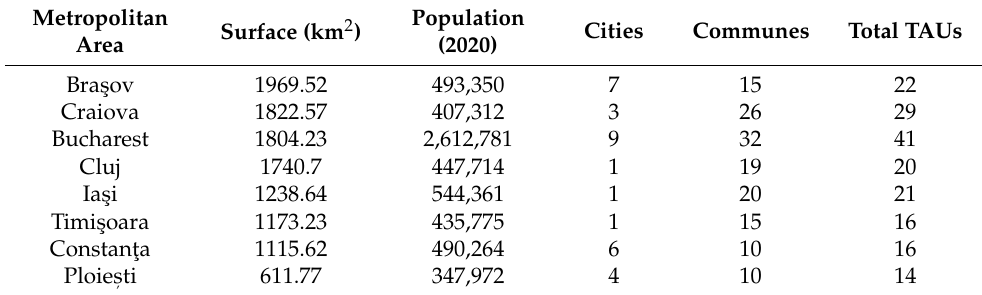
Figure 1. The location of the eight metropolitan areas in Romania. Table 1. General data on the analyzed metropolitan